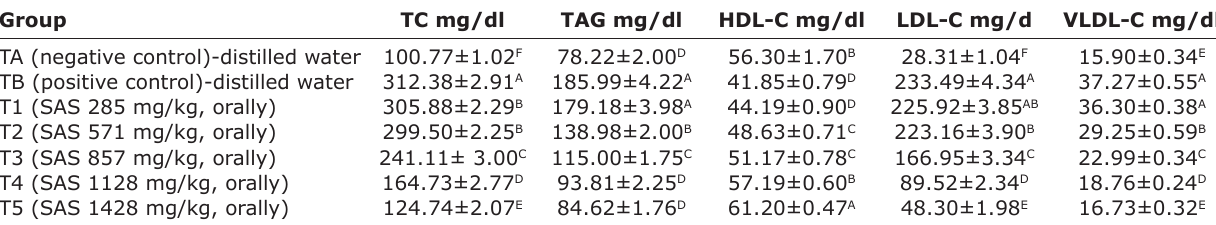
Table-2: The lipid profile of different groups of mice (controls and hyperlipidemic) treated with sweet almond suspension (SAS) in different doses daily for 60 consecutive